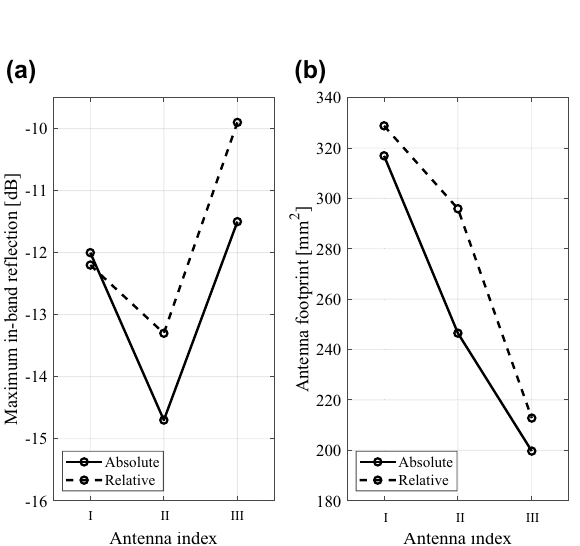
Table 5. Optimized geometry parameter vectors for the designs of Fig. 3.